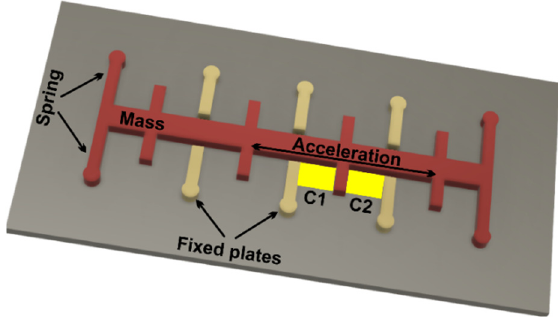
Figure 1. Microstructure of an accelerometer.